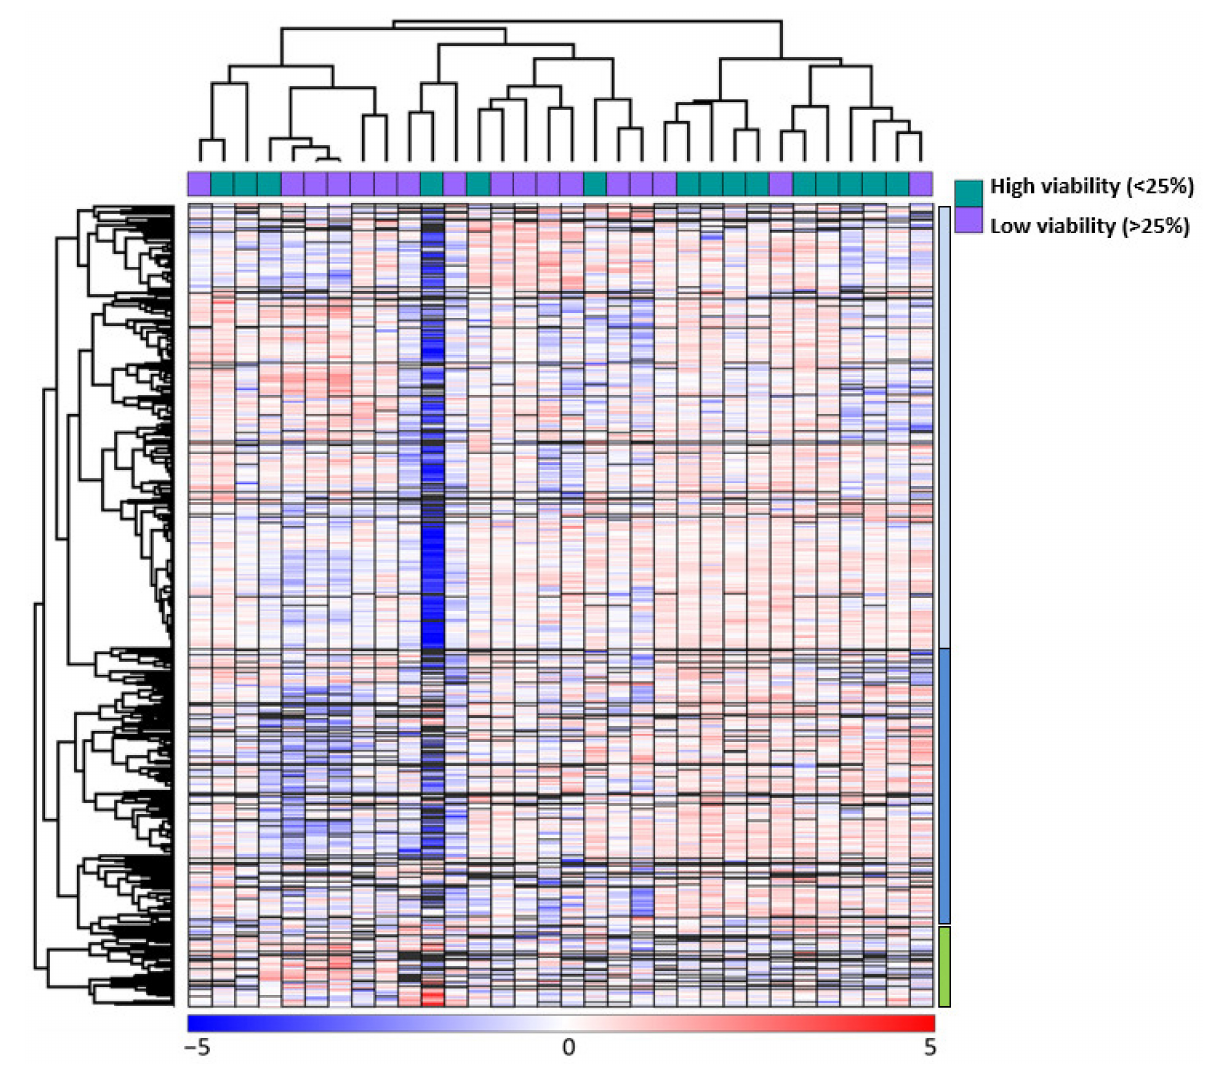
Figure 3. Unsupervised hierarchical clustering analysis based on the global proteomic profiles of primary AML cells during on-going spontaneous stress-induced in vitro apoptosis; an analysis based on all 7684 identified proteins. The analysis included 32 patients; for 15 of them, the AML cells showed high viability after 48 h of in vitro culture whereas for 17 of them low viability was observed; this classification is indicated at the top of the figure. Two main patient clusters were identified. The left main cluster included 20 patients and is referred to as patient cluster 1; this main cluster could be further divided into two patient subsets/subclusters 1.1 (left subset, n = 9)) and the right subset 1.2 including the remaining 11 patients. The right main cluster included 12 patients and is referred to as patient subset 2. Red color indicates a protein level higher than the corresponding median level for each individual protein, whereas blue color indicates a lower level than the corresponding median level (see the lower bar in the figure). We identified three protein subsets; the upper main protein cluster (referred to as protein cluster A) included the majority of proteins and could be further divided into two protein subsets/subclusters indicated by blue and dark blue color (see right part of the figure; referred to as upper Subset A1 and lower A2 cluster in the text). The second main protein cluster included a small group of proteins and is referred to as protein cluster B (indicated by green, see lower right in the